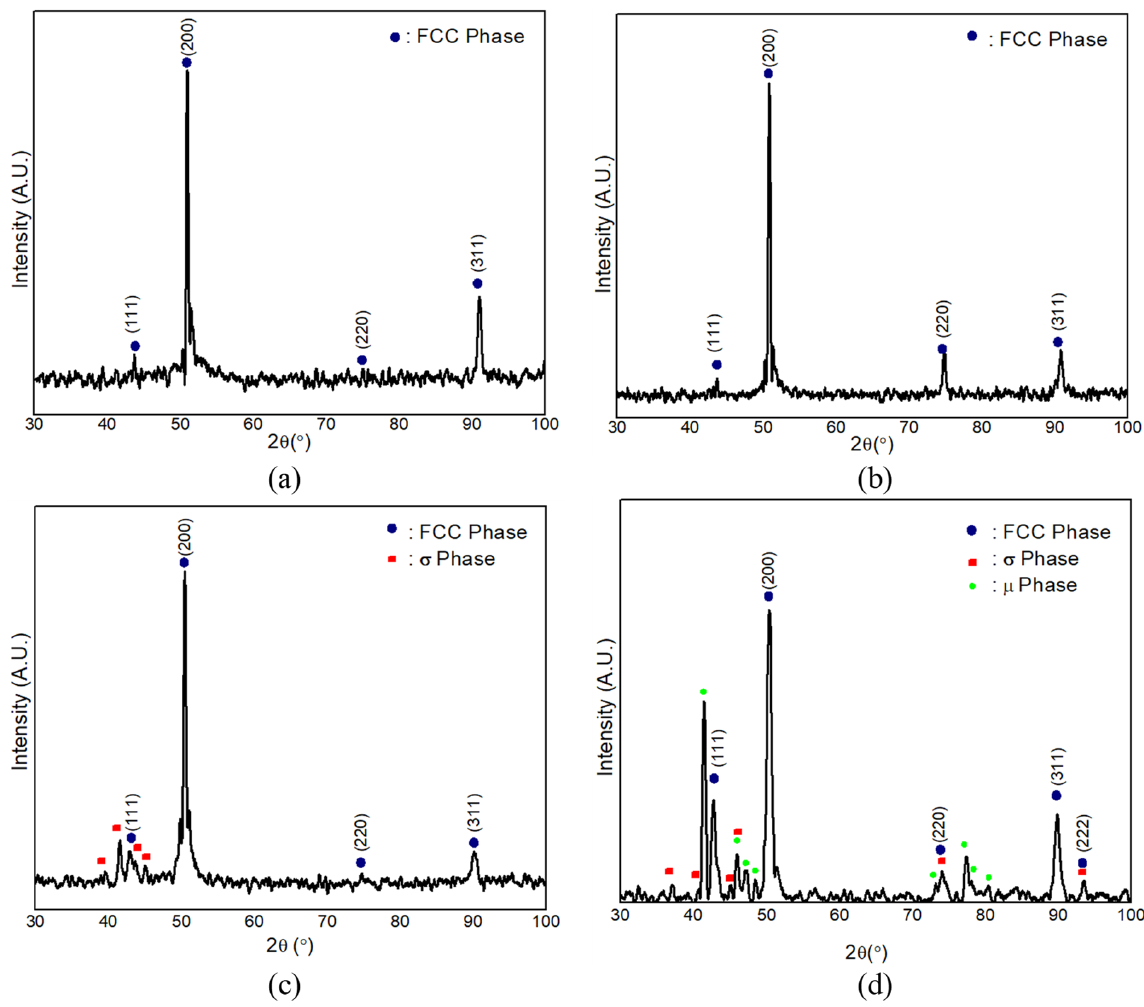
Figure 2. XRD patterns of developed HEAs: ( a ) CoCrFeNi-Mo 0.1 , ( b ) CoCrFeNi-Mo 0.25 , ( c ) CoCrFeNi-Mo 0.5 , ( d ) CoCrFeNi-Mo 1.0 .